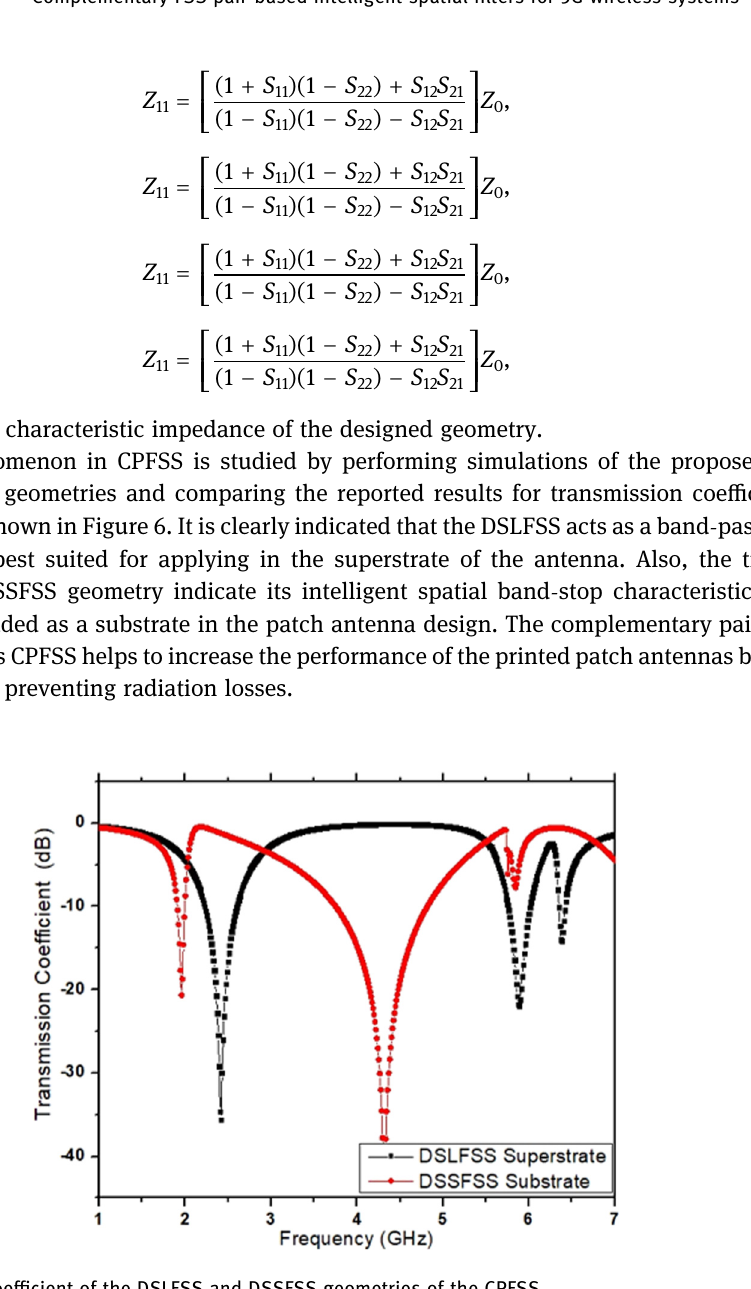
Figure 6: Transmission coe ffi cient of the DSLFSS and DSSFSS geometries of the